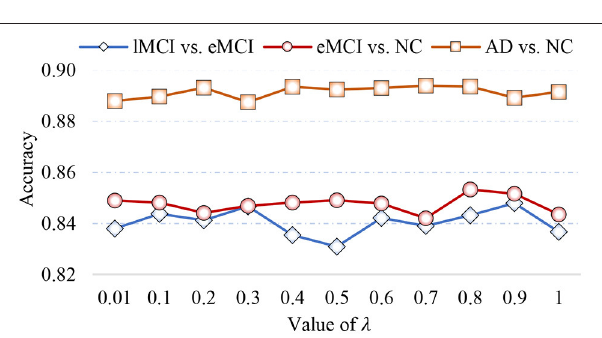
FIGURE 8 | Classification accuracy achieved by the proposed method using different values of λ in three classification tasks.